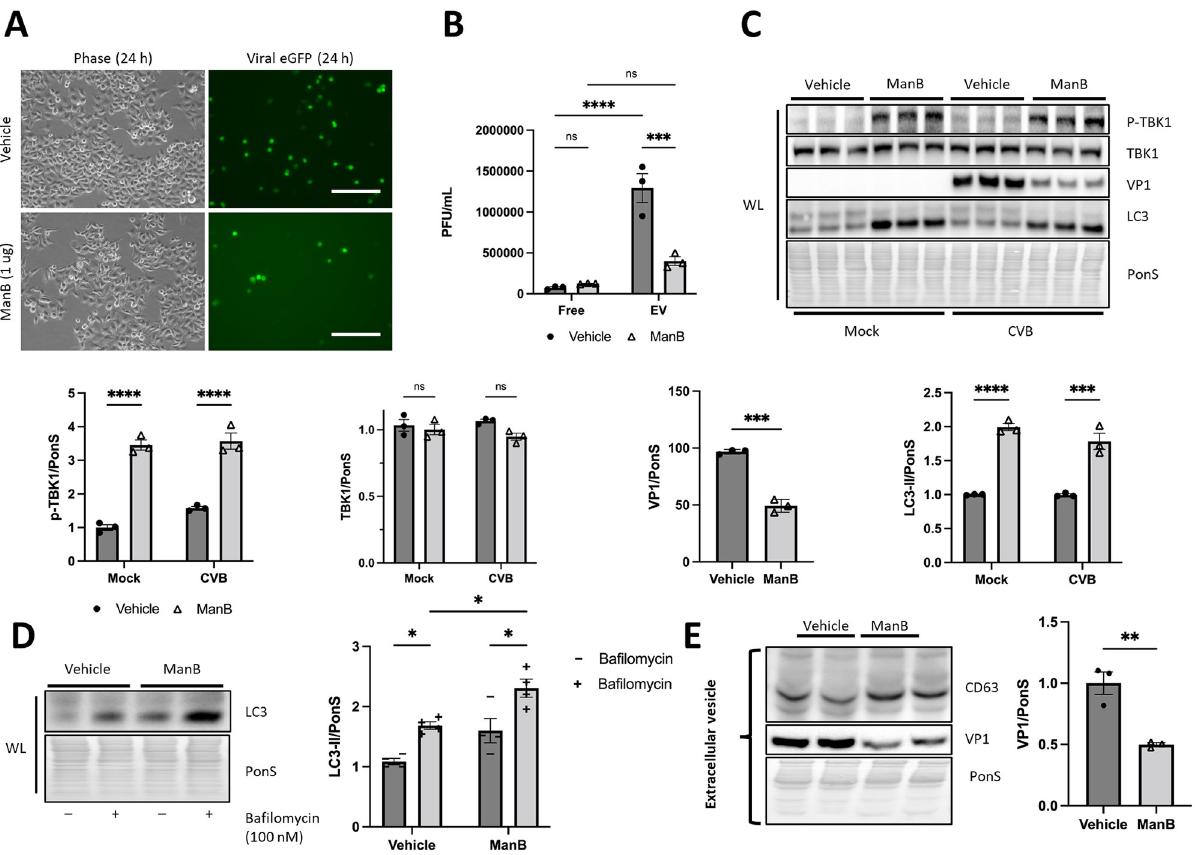
Fig 6. Activating TBK1 with Manassantin B suppresses CVB infection and secretion into EVs. HeLa cells were treated with 1 μ g ManB 24 h prior to infection with eGFP-CVB for an additional 24 h. (A) Fluorescence microscopy images of cells infected at MOI 0.01 for 24 h. Phase contrast images show similar cell density at 24 h p.i. Scale bars represent 100 μ m. (B) Extracellular viral titers of cells infected at MOI 0.1 for 24 h as measured by plaque assay. ��� , p < 0.001, ���� , p < 0.0001, two-way ANOVA; n = 3. (C) Western blots of mock-infected and CVB-infected cells at MOI 0.01 for 24 h. Densitometric quantification of Western blots. ��� , p < 0.001, ���� , p < 0.0001, two-way ANOVA or Student t test; n = 3. (D) Western blot of cells treated with bafilomycin (100 nM) for 2 h following treatment with ManB (1 ug) or vehicle for 24 h. Densitometric quantification of LC3-II. � , p < 0.05, two-way ANOVA; n = 4. (E) Western blot of EV lysates from CVB-infected cells including densitometric quantification of VP1. �� , p < 0.01, Student t test; n = 3. Data are representative of 3 experiments. WL = whole